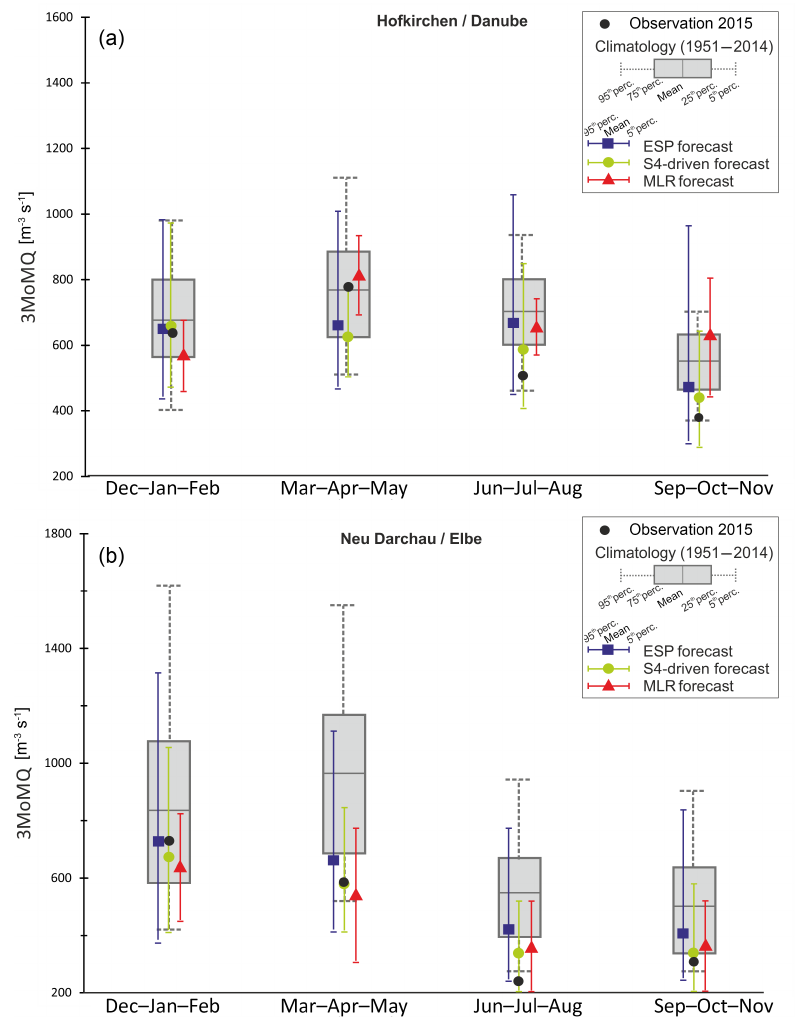
Figure 14. Comparison between the statistical forecast approaches for the monthly mean flow of the next 3 months 3MoMQ initialized in December 2014, March 2015, June 2015, September 2015 at gauges Hofkirchen/Danube (a) and Neu Darchau/Elbe (b) in relation to the observed values and the climatology